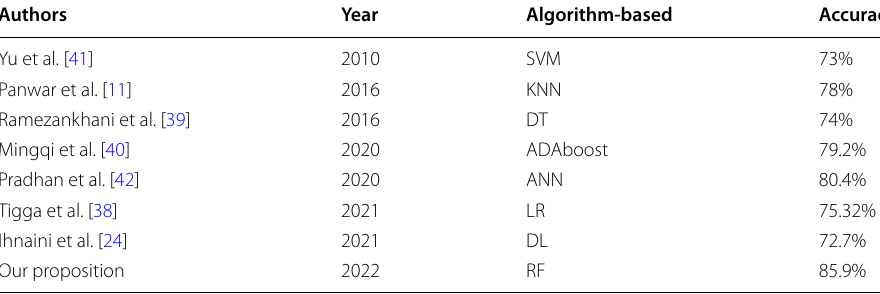
Table 4 Summary of the different algorithms on Dataset1 Authors Year Algorithm‑based